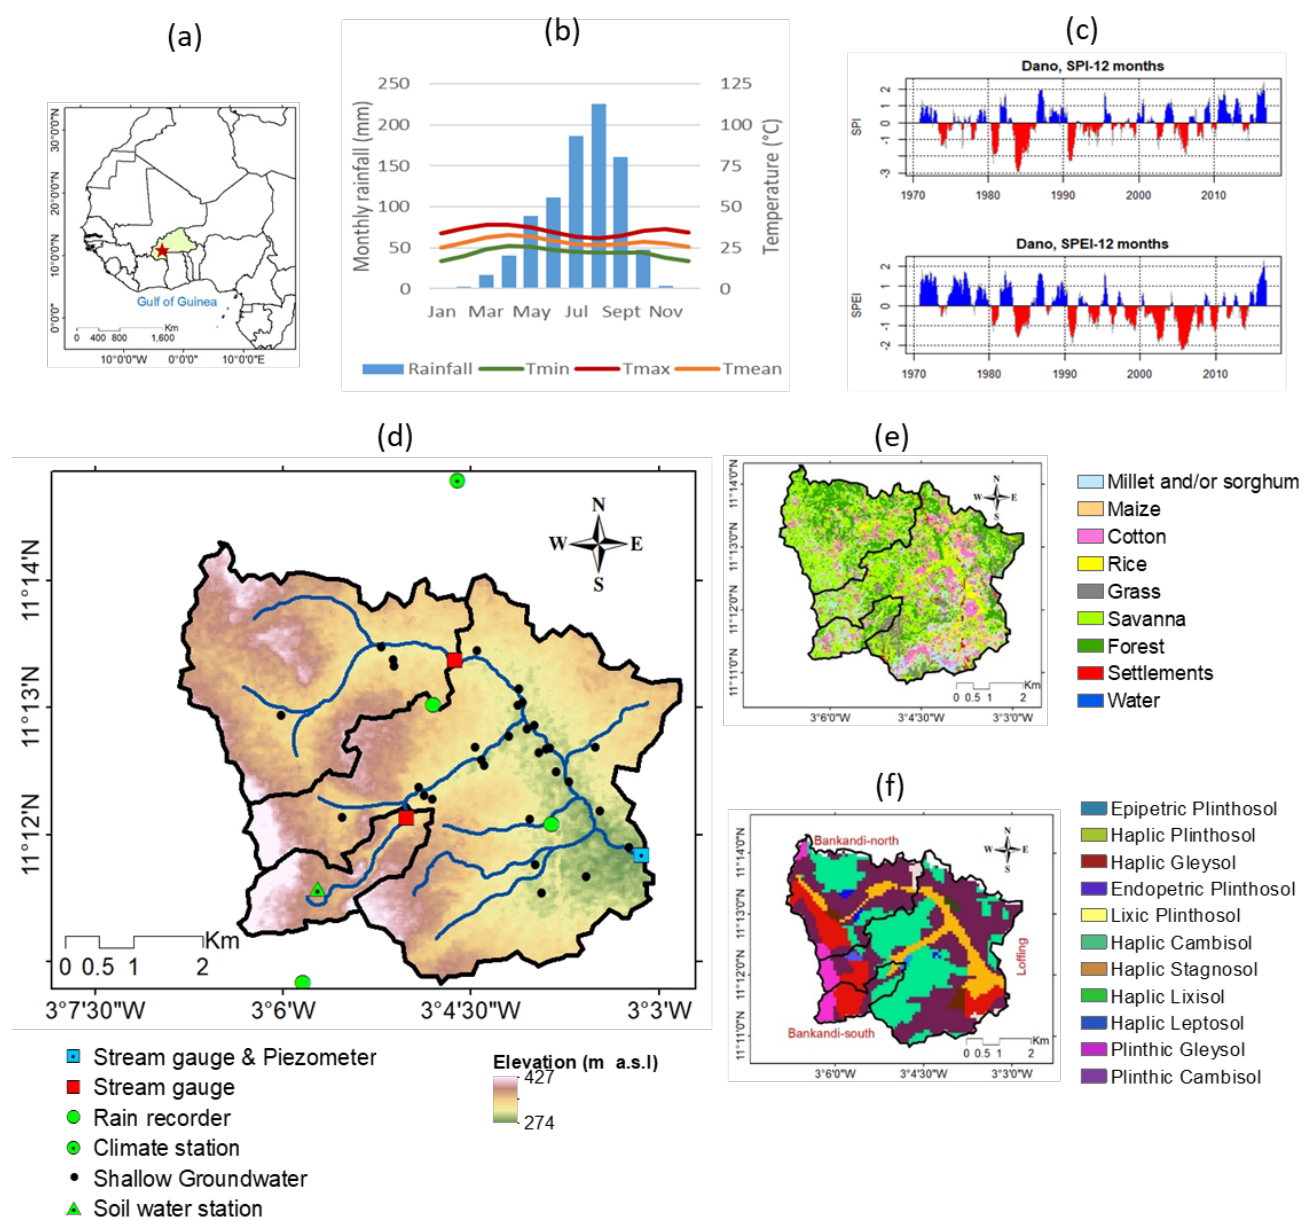
Figure 1. Location map of the Bankandi-Loffing catchment in Dano. ( a ): Catchment location in Burkina Faso and West Africa, the marking (“pentagram”) shows the position of the catchment in Burkina Faso; ( b ): monthly mean rainfall and temperature from 1970 to 2016; ( c ): 12 month Standardized Precipitation Index (SPI) and Standardized Precipitation Evaporation Index (SPEI) values for the period of 1970–2016; ( d ): instrumentation of the Bankandi-Loffing catchment and the considered sub-catchments; ( e ): land use land cover of the catchment in the year 2013; ( f ): soil attributes of the catchment. (Data sources: country outlines: www.maplibrary.org, 1 April 2020; historical rainfall and temperature: National meteorology service of Burkina Faso; digital elevation: Shuttle Radar Topography Mission (SRTM) 1 Arc-Second by NASA; land use land cover: [51], soil type: [52]).